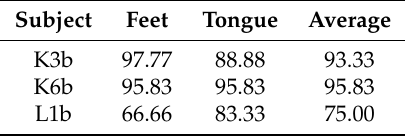
Table 3. The label wise accuracy (%) of each subject for foot and tongue MI tasks.